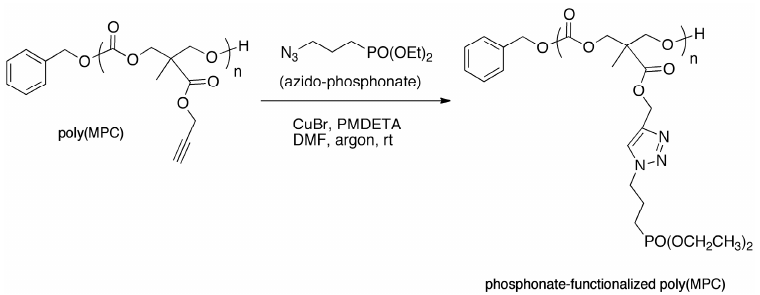
Figure 6. Overlaid 1 H NMR spectra of poly(MPC) 46 in CDCl 3 before and after the “click” reaction with azido-phosphonate in acetone D 6 . 4. Conclusions We have successfully demonstrated two strategies for synthesizing polycarbonate- bearing pendant phosphonate groups. For the first time, a well-defined phosphonate- functionalized polycarbonate was directly synthesized using organocatalyzed ROP of new phosphonate containing cyclic carbonate. The copolymerization of phosphorus mon- omer was also performed to access the various structures of polycarbonate-containing phosphonate groups. Furthermore, copolymerization could be a useful approach for